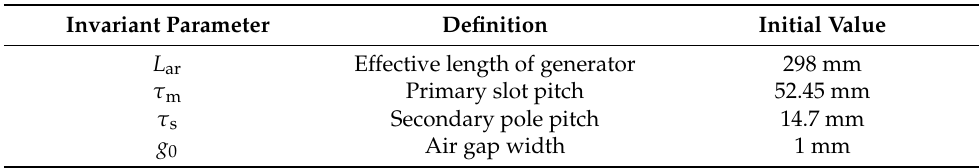
Table 3. Constant structural